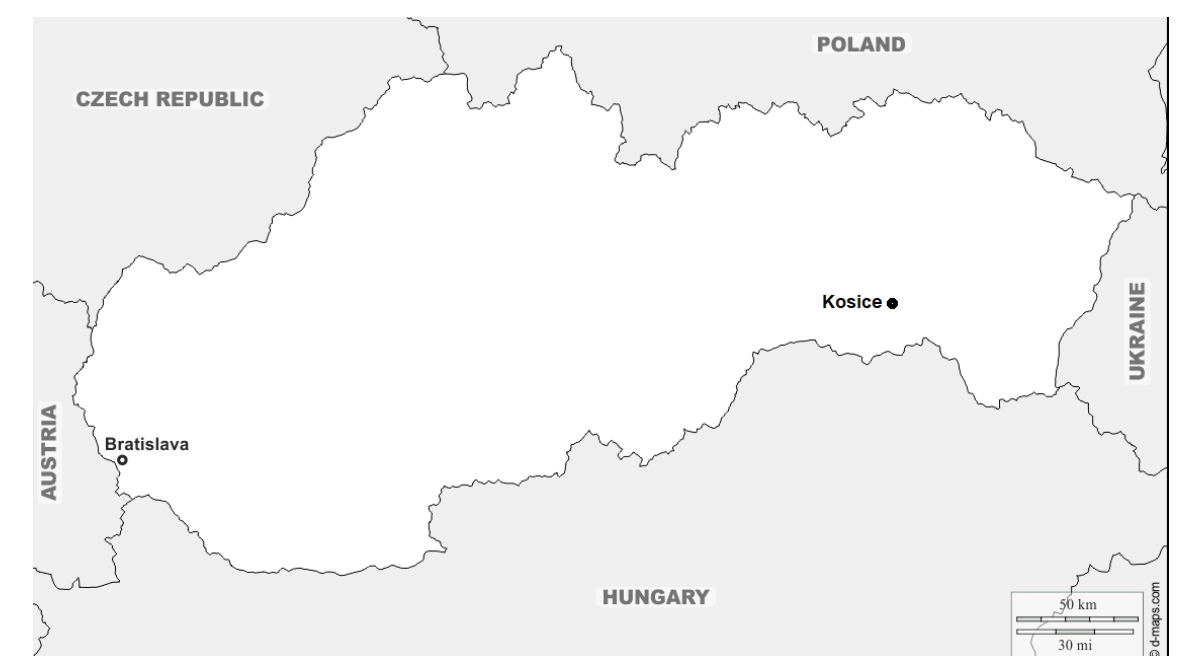
Figure 1. Location of the Slovak Republic and the town of Kosice [64].